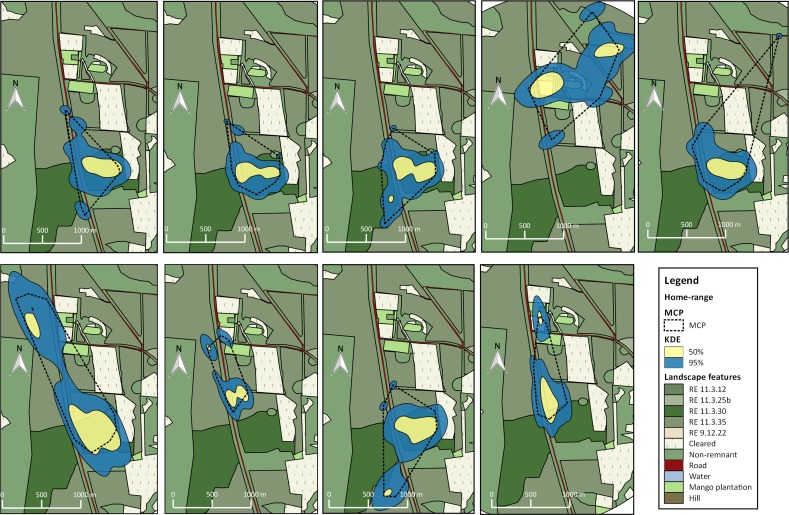
Home ranges for 9 individuals of BTF southern subspecies Poephila cincta cincta calculated with 95%kde (blue fill), 50%kde (yellow fill) and MCP (dashed line) at Site 2, near Townsville, eastern Queensland.